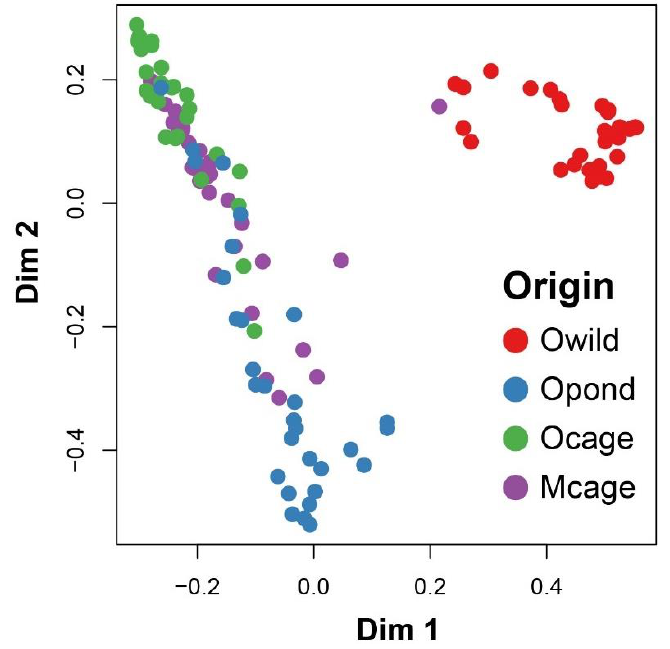
Figure 2. Multidimensional scaling (MDS) ordination of proximity scores from random forest classifications based on elemental fingerprints of Sparus aurata muscles collected at the following four sampling origins: Olhão – wild (Owild), Olhão – aquaculture in earth ponds (Opond), Olhão – sea-cage aquaculture (Ocage) and Madeira – sea-cage aquaculture (Mcage).